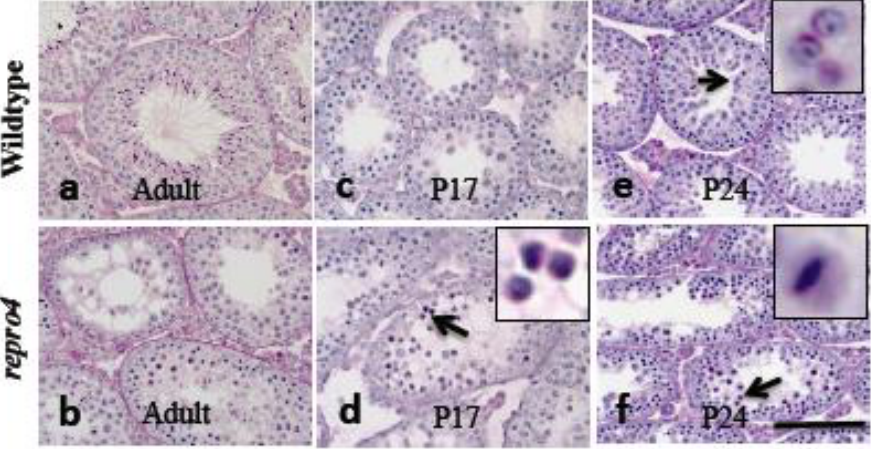
Figure 1. Spermatogenesis is arrested predominantly during prophase of meiosis I in repro4 mutants. PAS-stained testis sections from repro4 mutants and WT littermate controls reveal that spermatogonia, spermatocytes and spermatids are present in testes of adult WT mice ( a ), whereas in repro4 mutant testes, most tubules contain only spermatogonia and spermatocytes ( b ). By P17, during the first wave of spermatogenesis, WT and repro4 mutant testis tubules were populated with spermatocytes, but repro4 mutants ( d ) exhibited more spermatocytes with highly condensed chromatin (arrow and inset) than did WT testes ( c ). By P24, round spermatids were present in WT testes ( e , arrow and inset), but repro4 mutant testis tubules contained primarily prophase and a few metaphase spermatocytes ( f , arrow and inset). Scale bar for a – f = 100 µm.